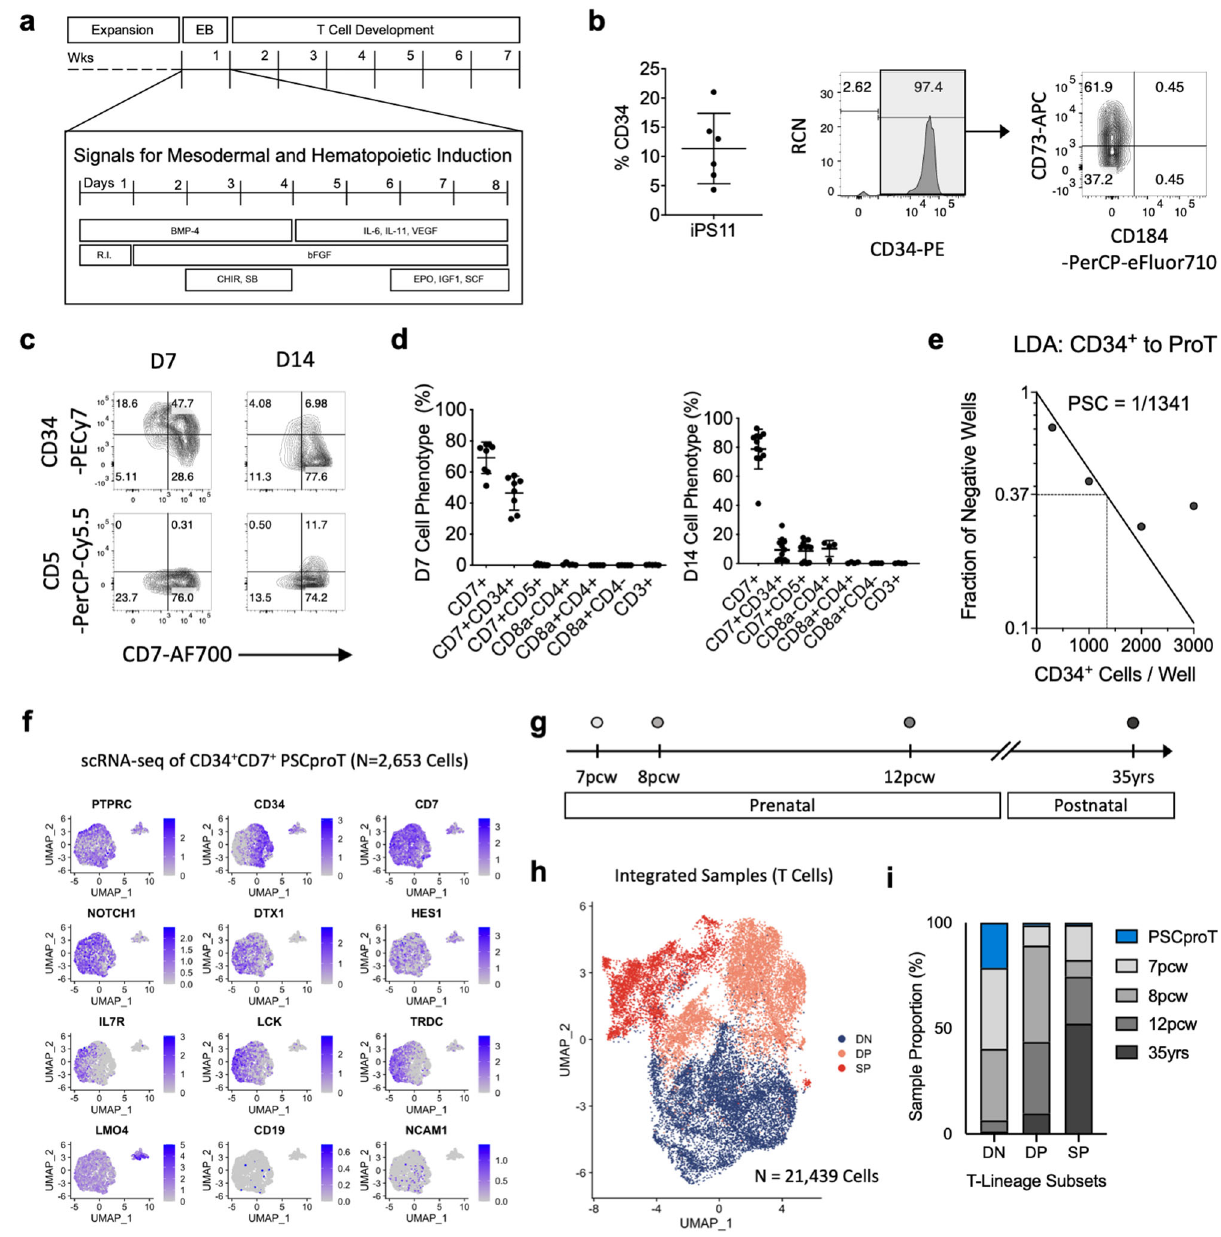
Fig. 3 T cell development from human pluripotent stem cells using DL4- μ beads. a Differentiation scheme used for hematopoietic induction and T cell development of human PSCs. EBs were generated from IPS11 cells during the fi rst 24 h of culture and differentiated in chemically de fi ned media with an optimized, stage-speci fi c combination of BMP-4, bFGF, and VEGF together with hematopoietic cytokines as indicated. b Proportion of CD34 + cells at D8 harvest before CD34 + MACS-enrichment. Surface expression of CD184 and CD73 on CD34 + -gated cells post CD34 + MACS-enrichment ( n = 6). c Representative fl ow cytometry plots of human iPSC-derived CD34 + cells cultured for 7 and 14 days with DL4- µ beads in serum-free media. Cells were harvested and analyzed for the surface expression of CD34, CD5, and CD7 using fl ow cytometry. d Frequencies of the indicated proT-cell phenotypes after 7 days or 14 days, for the markers shown in c as well CD3, CD4 and CD8 (not shown) ( n = 6). e Limiting dilution assay of iPSC- CD34 + cells. MACS- enriched iPSC-CD34 + cells were placed in limited numbers in wells of a 96-well plate containing DL4- µ beads and cultured for 14 days before harvesting for fl ow cytometric analysis. Individual wells were scored for the presence of T-lineage cells based on CD45 + CD7 + CD56 − . Statistical analysis was performed via the method of maximum likelihood applied to the Poisson model, and shown in Supplementary Table 1. f Single-cell RNA sequencing of 2,653 D7 iPSC- proT cells (GSE169279). UMAP visualization of the expression of genes from iPSC-proT sequencing data associated with early T cell development, Notch activation and alternative lineages. g Summary of the gestational age of human thymus single-cell RNA sequencing data retrieved from public repository (ArrayExpress: E-MTAB-8581). h UMAP visualization of integrated and batch-corrected sequencing data from PSC-proT and primary human thymocytes. Cell types are colored and annotated (DN = double-negative T cells; DP = double-positive T cells; SP = single-positive T cells). i Proportion of each sample within each T-lineage subset. Data represent means± s.d. of n independent experiments.